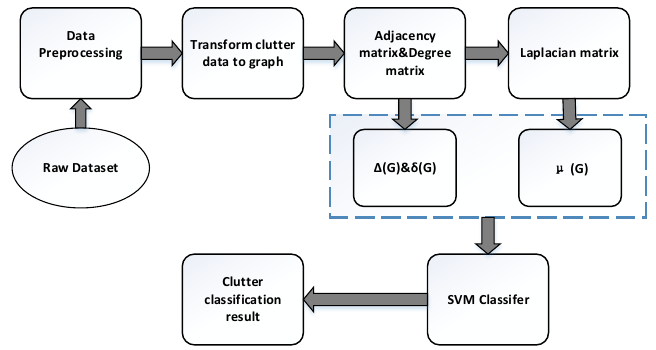
Figure 1. Flowchart of the proposed